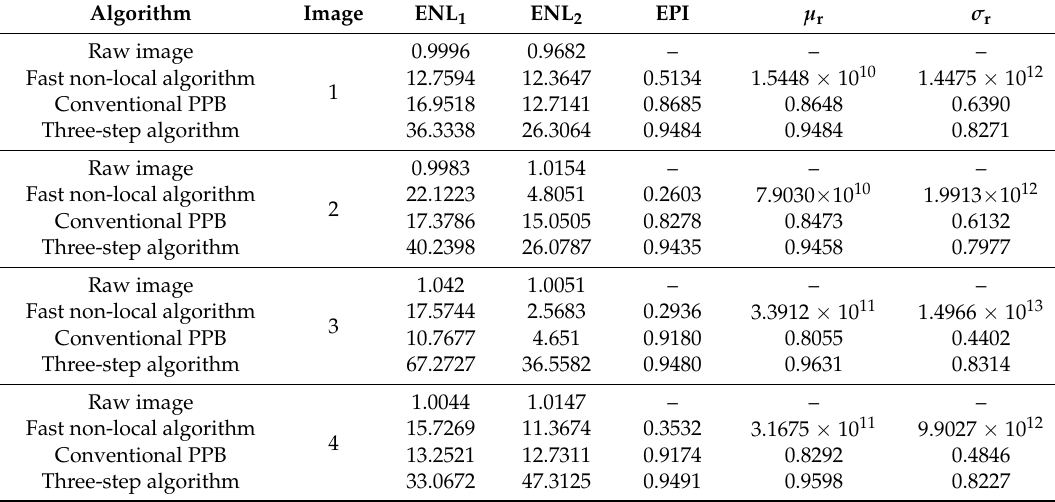
Table 1. Evaluation